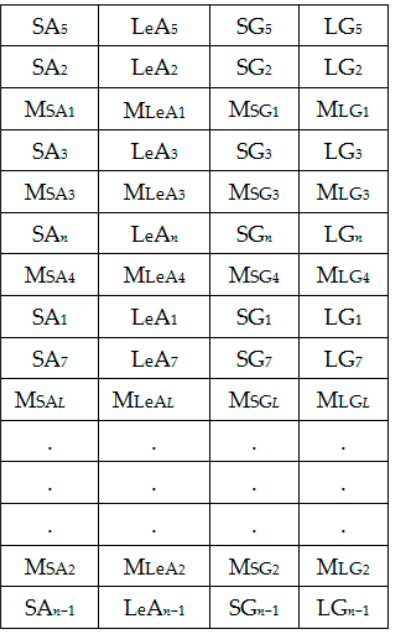
Figure 9. Randomly shuffled (OR + LA1 + SH) feature set 2.